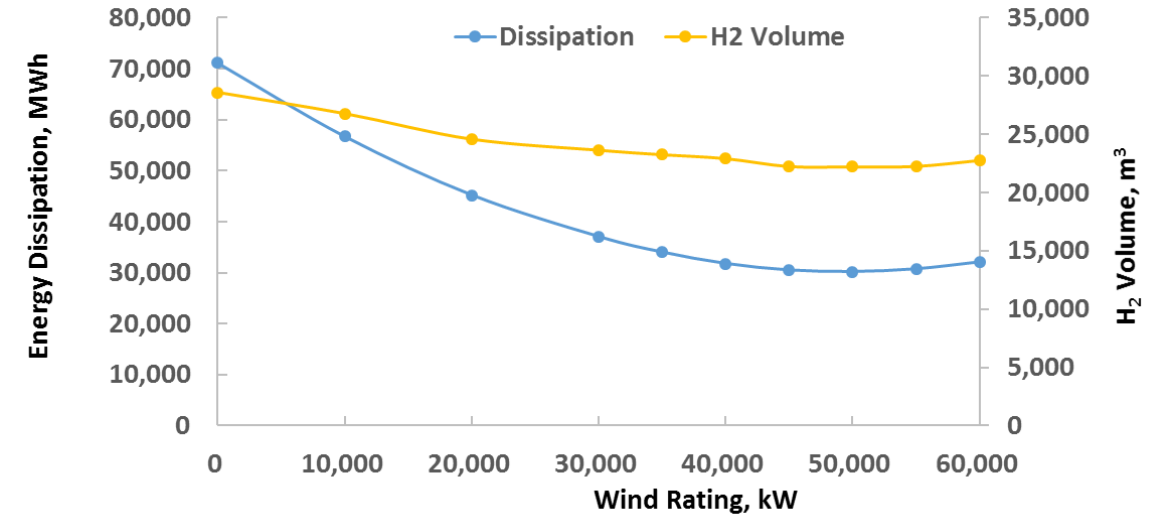
Figure 6. Annual energy dissipation and volume of hydrogen storage needed for the storage– regeneration process.